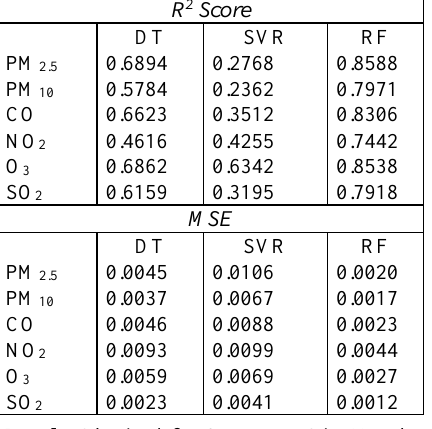
Table 3. Results Obtained for Guanyuan City Weather Station